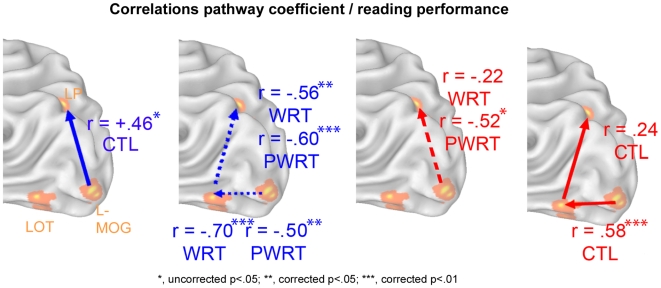
Correlations pathway coefficient/reading performance.Significant (FDR corrected or uncorrected) Spearman positive (full arrows) or negative (hashed arrows) correlation coefficients between off-line reading tests (WRT, PWRT, CTL) and effective connectivity values of on-line word (blue) and pseudoword (red) reading. WRT, Word reading Response Time test; PWRT, Pseudoword reading Response Time test; CTL, speed and precision index used in the “Alouette-R” test. L-MOG, left middle occipital gyrus; LOT, left occipito-temporal junction; LP, left parietal cortex; L-IFG, left inferior frontal gyrus.